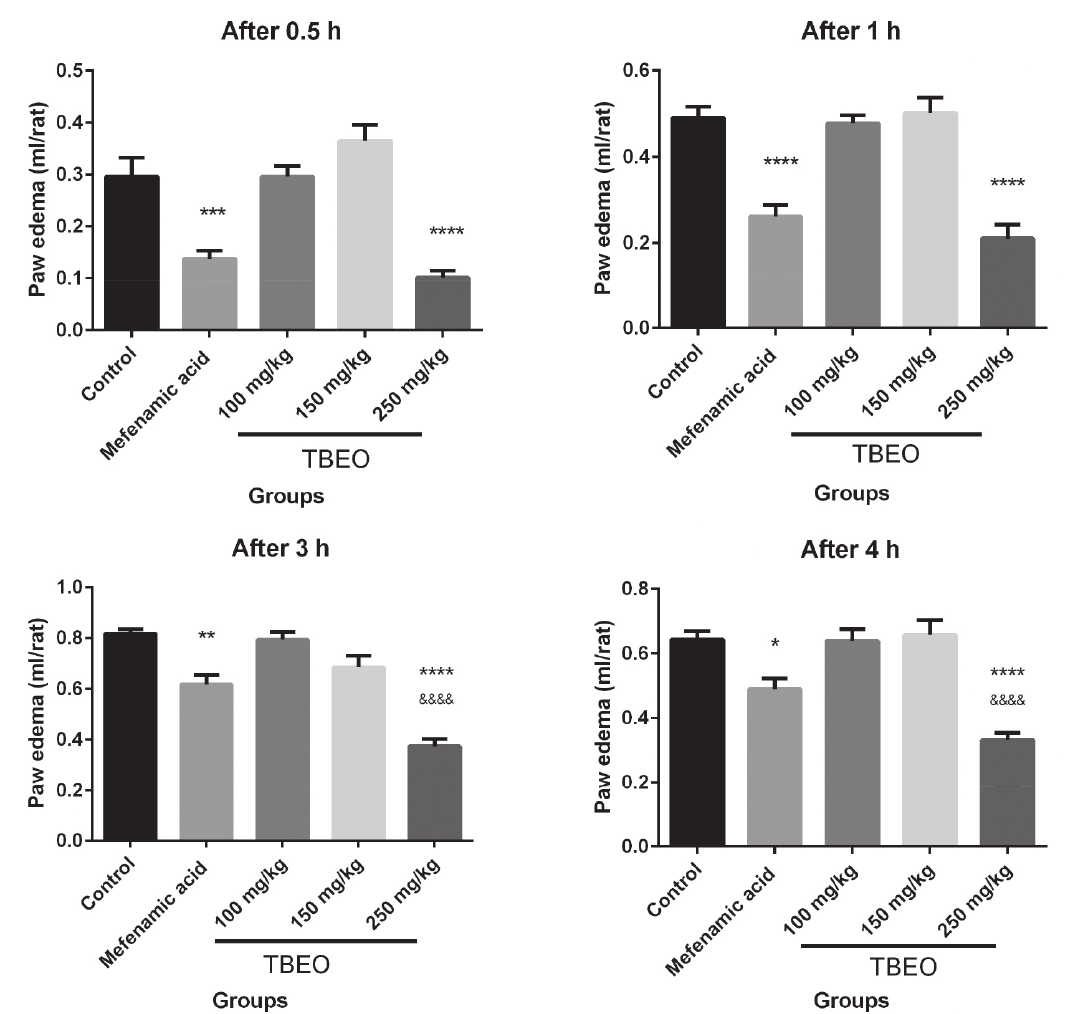
FIGURE 3 - Effects of TBEO on Carrageenan induced inflammation in the 0.5, 1, 3 and 4 hour after the injection of carrageenan. Values represent Mean ± SEM (n = 6 - 8). *P < 0.05, **P<0.01, ***P<0.001 and ****P<0.0001 in compared to control, &&&& P<0.0001 in compared to Mefenamic